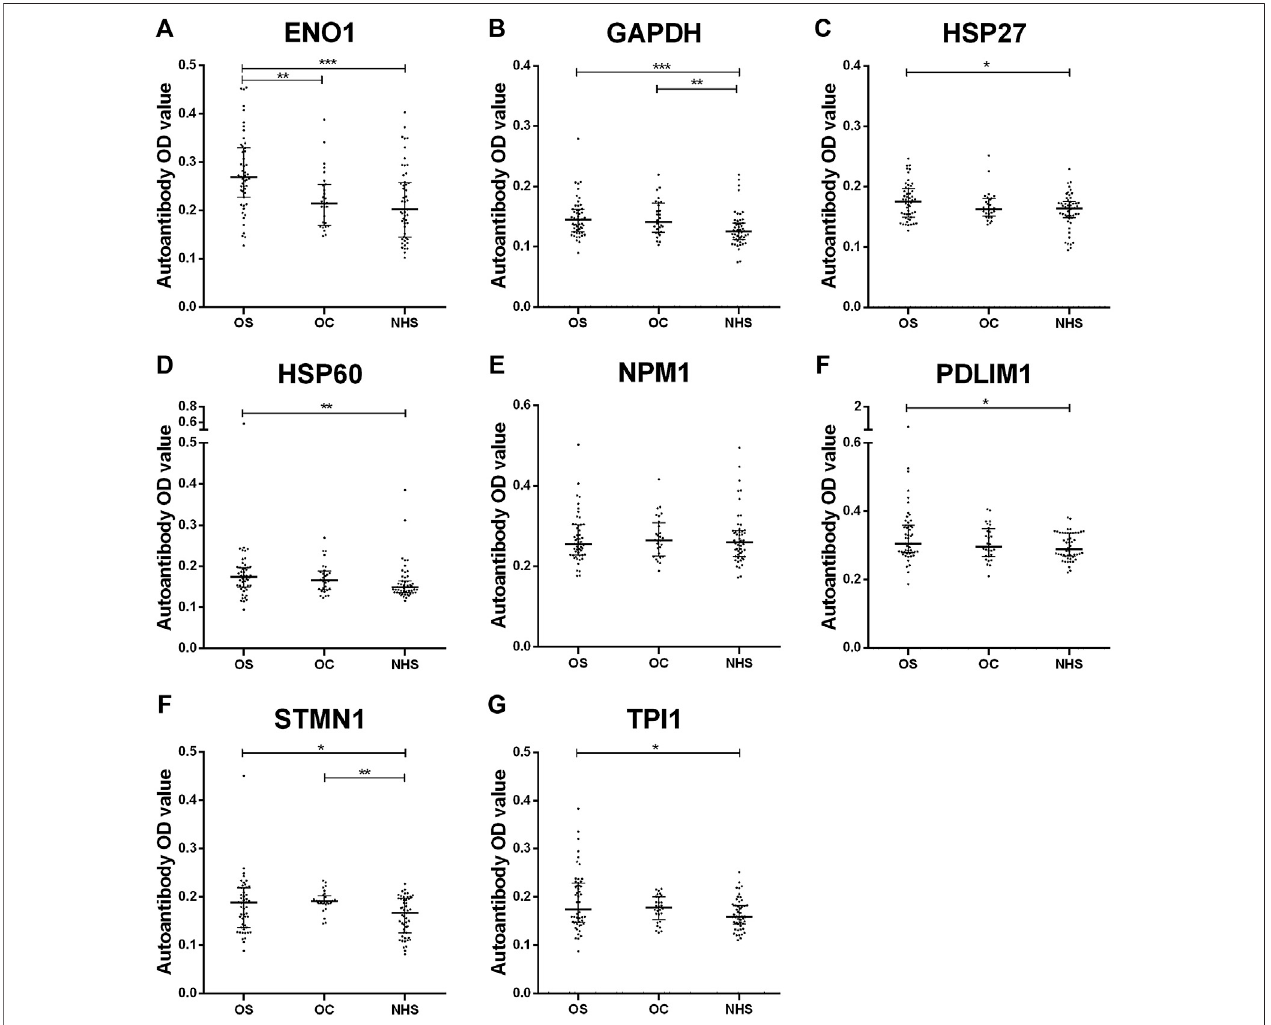
FIGURE1| ScatterplotsofserumlevelsofautoantibodiesagainsteightTAAsinOS,OCandNHS(medianwithinterquartile). p < 0.001; p < 0.01;and p < 0.05.OS, osteosarcoma; OC, osteochondroma; NHS, normal human sera.